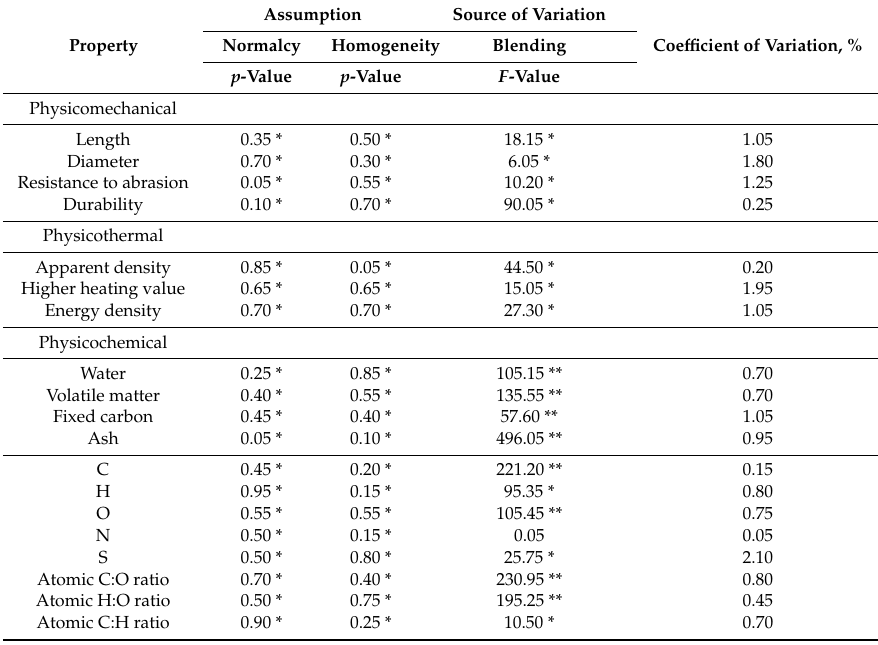
Table 2. Analysis of variance for the effect of blending of residual biomass from distillation of cellulosic bioethanol on the quality of hybrid non-wood pellets. Assumption Source of Property